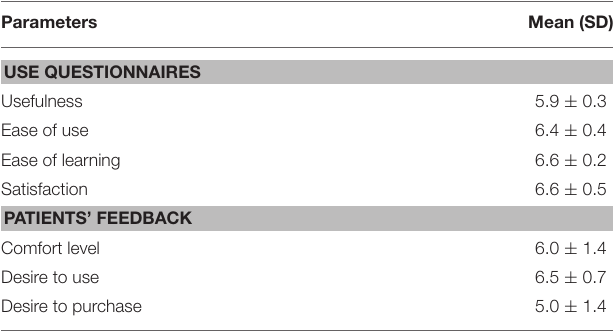
TABLE 3 | Questionnaire parameters and relative ratings of the USE questionnaire and a questionnaire focusing on comfort level, desire to use, and desire to purchase the